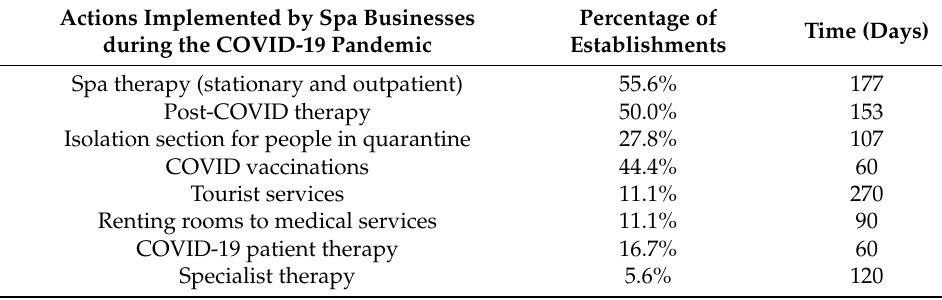
Table 4. Structure of functions performed by spa